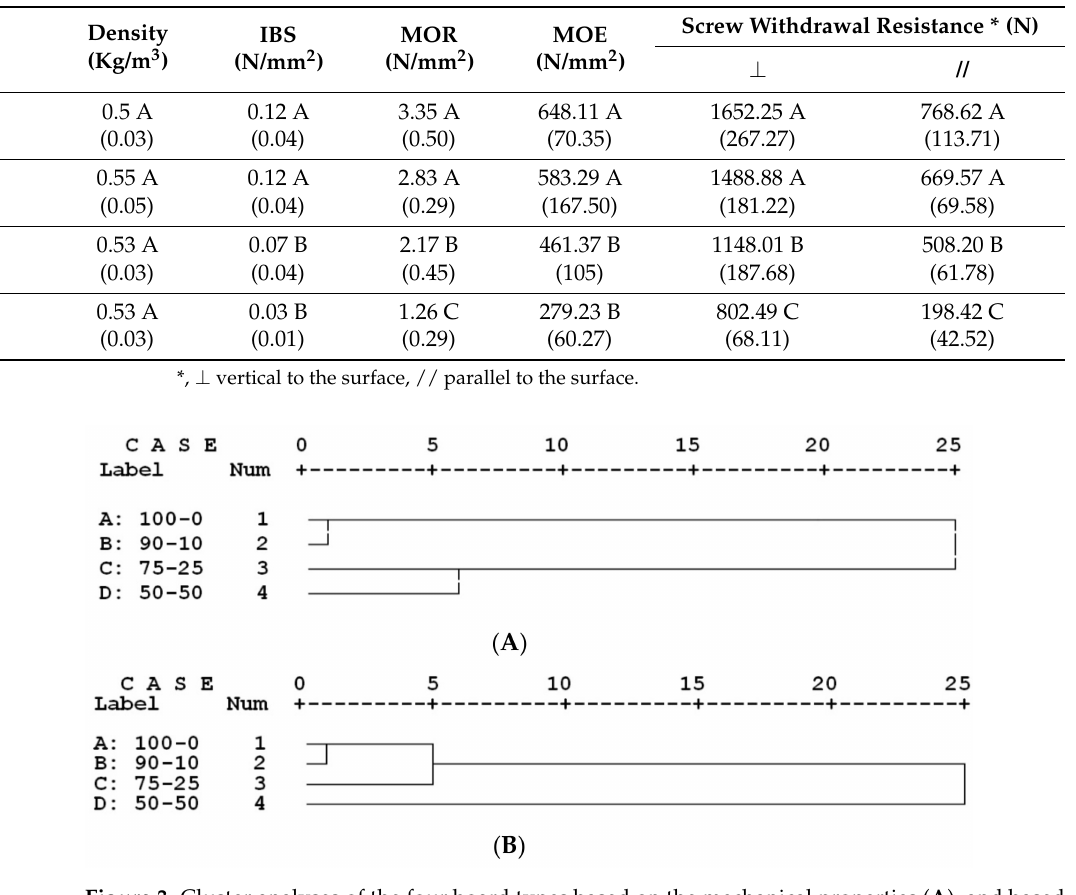
Figure 3. Cluster analyses of the four board types based on the mechanical properties ( A ), and based on all physical and mechanical properties ( B ).